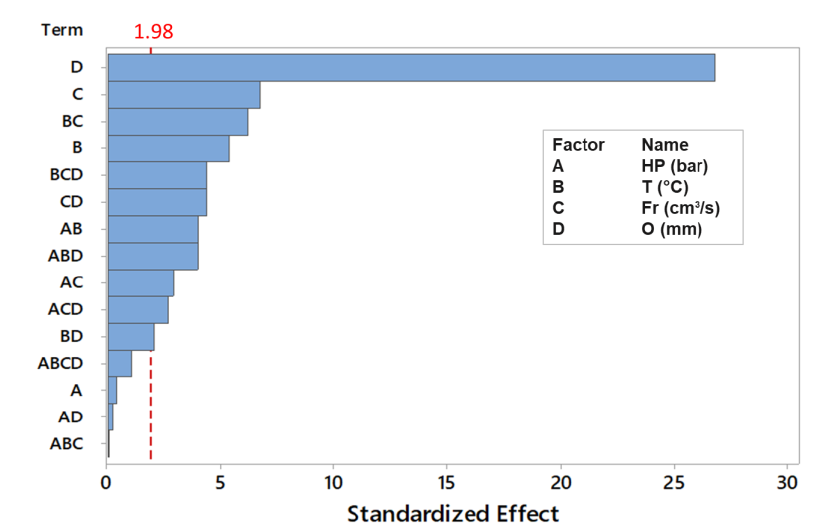
Figure 7. Standardized effects of the process parameters.